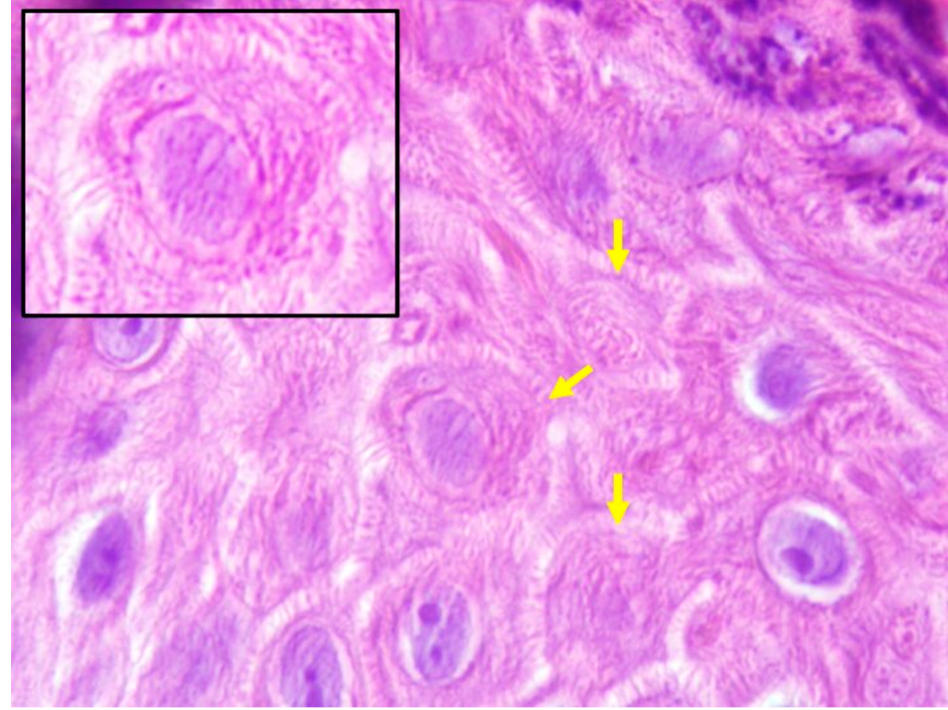
Figure 2. The fingerprint sign. Keratinocytes with striated cytoplasm (Hematoxylin-Eosin ×1000).